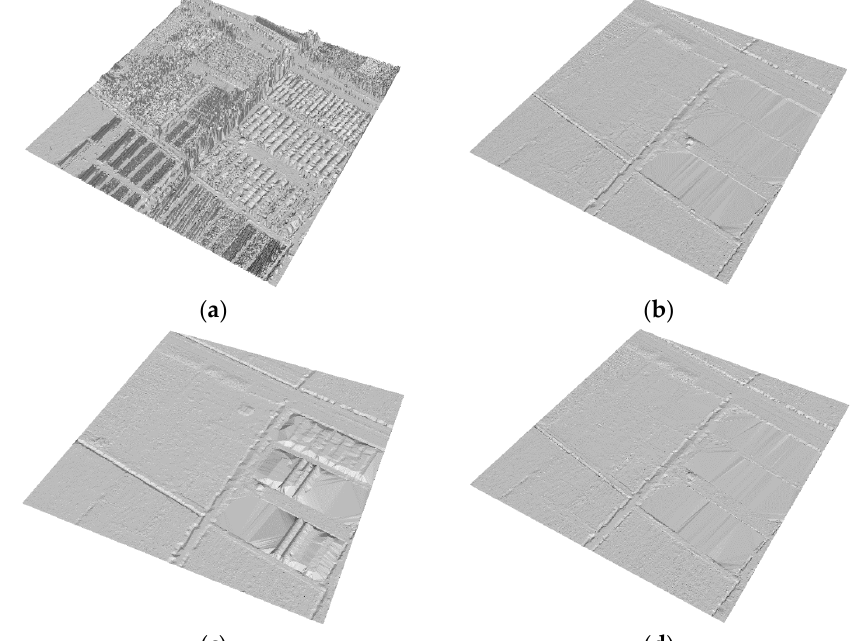
Figure 10. Comparison of the proposed method and TerraScan on the details of the plain area: ( a ) raw ALS data; ( b ) ground truth; ( c ) result of TerraScan; and ( d ) result of deep CNN model.